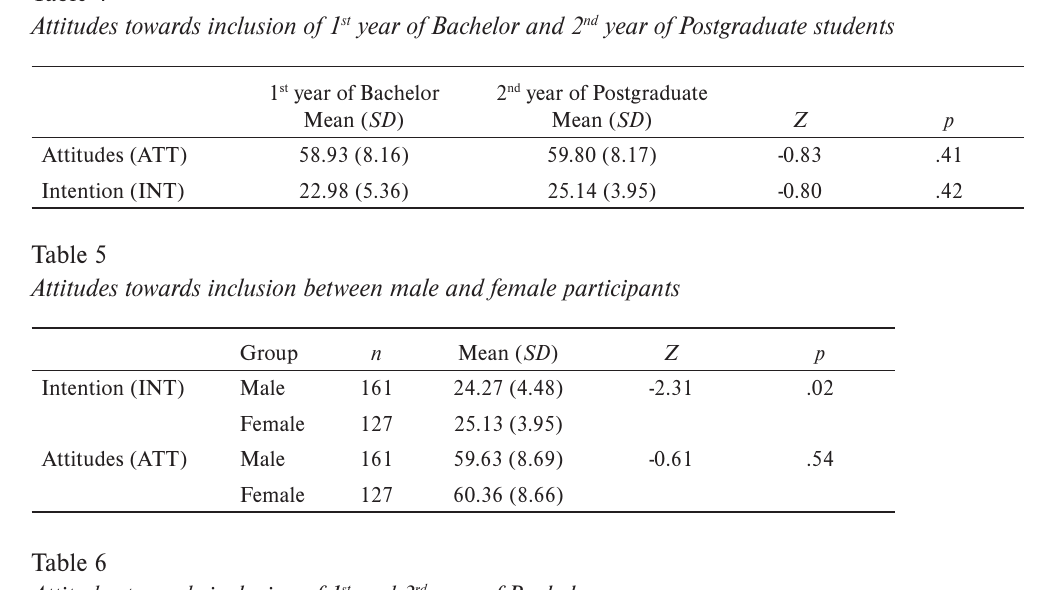
Attitudes towards inclusion of 1 st and 3 rd year of